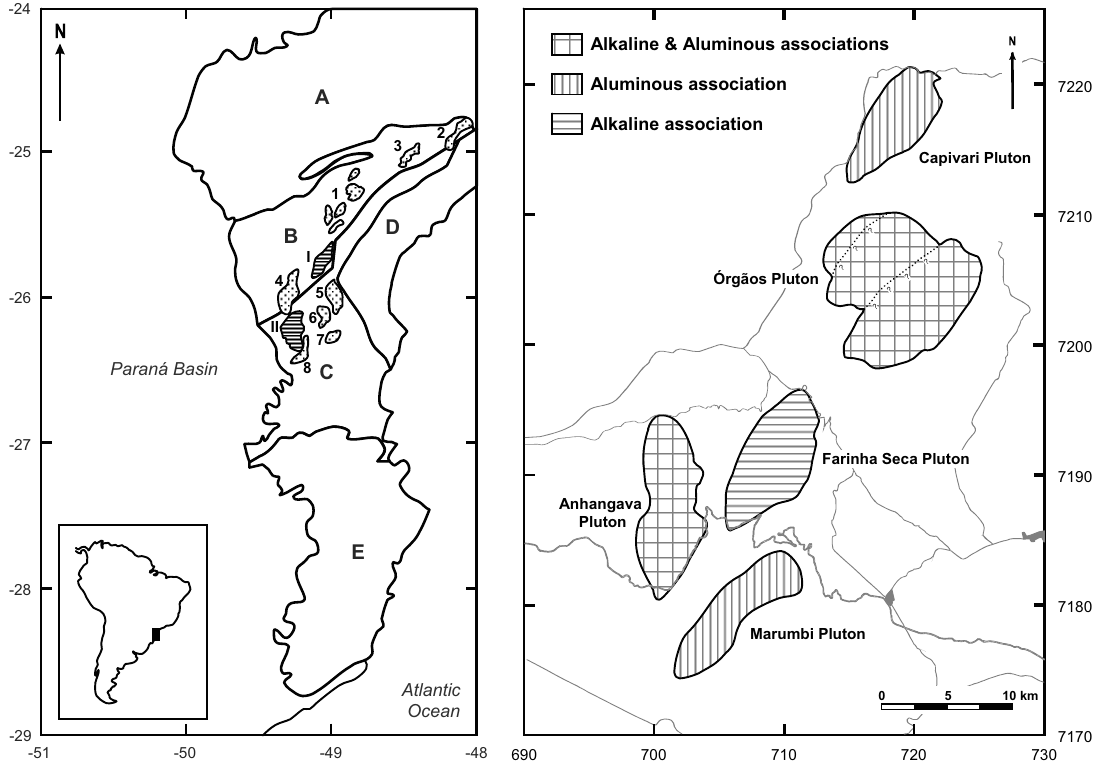
Fig. 1 – The Graciosa Province in southern Brazil (left panel). The main tectonic units in southern Brazil are indicated - A: Ribeira Fold